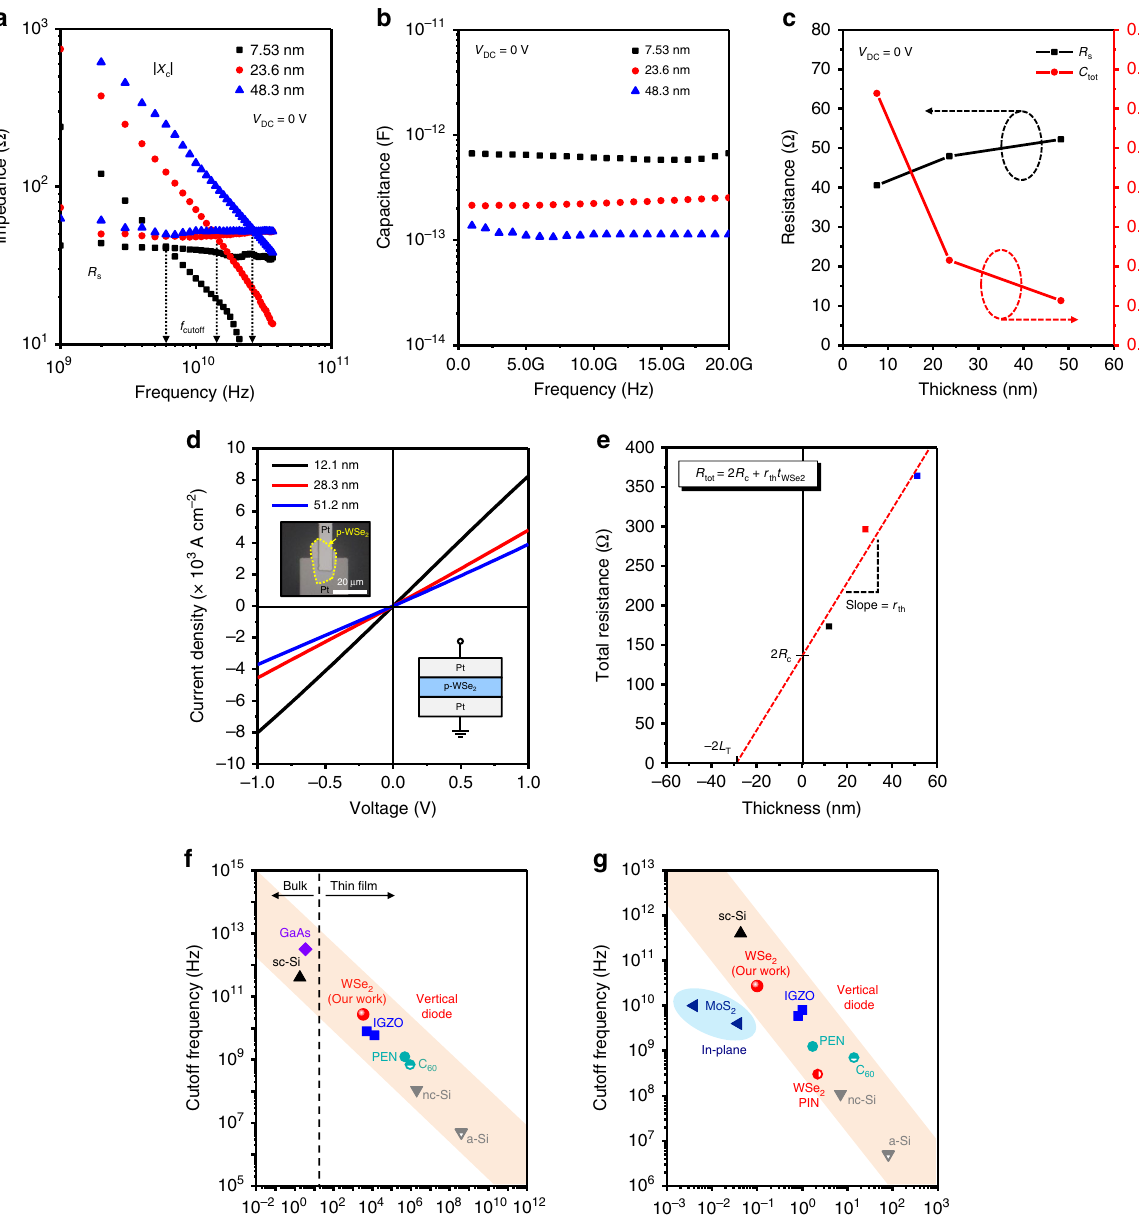
Fig. 4 WSe 2 thickness-dependent cutoff frequency behavior and extremely small contact resistance. a R s and | X c |( = 1/ ω C tot ) plots as a function of frequency under zero external bias (battery free). The f cutoff is found at 27.1, 14.7, and 5.92 GHz for 48.3, 23.6, and 7.53 nm-thick WSe 2 when plotted without de-embedding. b Thickness-dependent capacitance values extracted from | X c |( = 1/ ω C tot ) plots. c R s and C tot plots as a function of WSe 2 thickness. Unlike capacitance, R s does not vary in the range between 40 and 52 Ω . d J – V characteristics of the Pt-WSe 2 -Pt diodes (inset) with different WSe 2 thicknesses of 12.1, 28.3, and 51.2 nm. They show straight ohmic behavior. e Total resistance-thickness ( R tot − t WSe2 ) plot extracted from J – V plots based on the same contact area ( A ct = 0.69 × 10 − 6 cm 2 ) of the G-S-G diodes. The red dashed line represents a linear fi tted line for the three R tot points with different t R Ω ( L = 28.2 nm, W = 8.3 μ m). This R R R R c is worked out to be 65 T c value is almost the same as that of s because s is mostly covered by c in high WSe2 . frequency RF measurement, and in fact should be constant regardless of measurement type. Figure of merit comparison in the plot of R ct vs. f cutoff ( f ) and in the other plot of C j vs. f cutoff ( g ). In view of f and g , our f cutoff utilizing 3400 Ω μ m 2 ( = 50 Ω × 69 μ m 2 ) and 0.10 pF appears quite outstanding, showing the best RF performance if those of bulk single-crystalline Si- and GaAs-based Schottky diodes are excluded. These results indicate that contact resistance and junction capacitance are dominating factors for high frequency